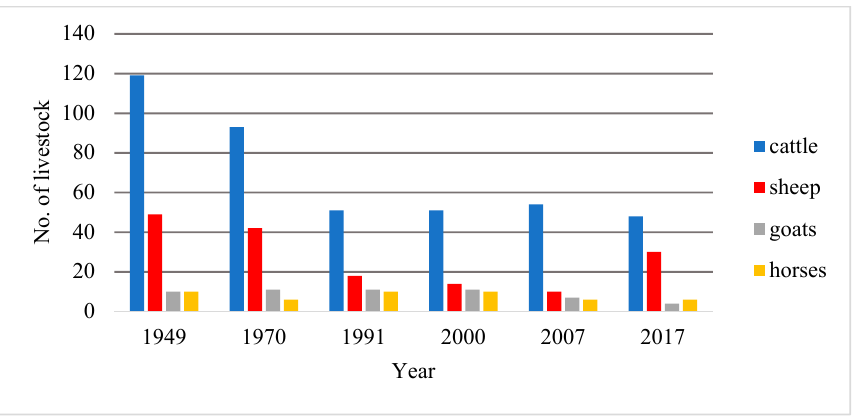
Figure 2. Number of livestock grazed in the orchards over the period 1949–2017 (not including livestock kept on the cooperatives and farms).